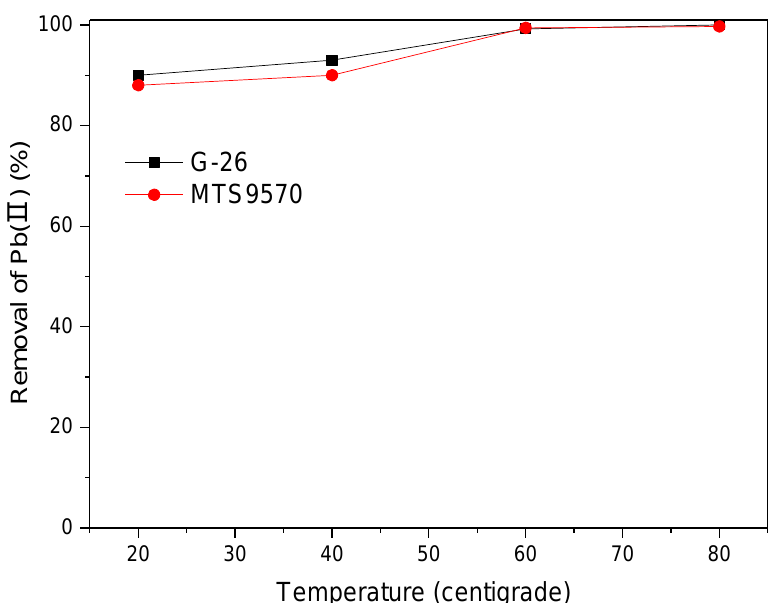
Figure 6. Effect of temperature on adsorption of Pb(II) using G-26 and MTS9570 reins at 0.5 g of resin dosage, 20 min agitation time, 150 rpm agitation speed, pH 3.5, and concentration 1000 mg/L .